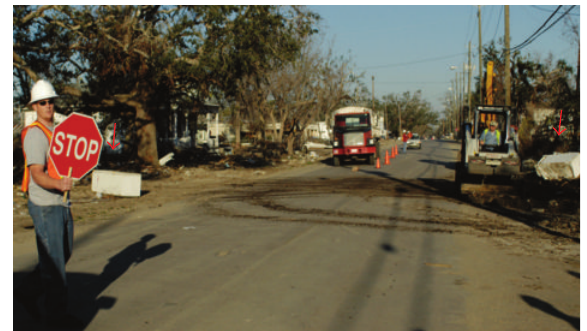
Figure 7: White goods placed in ROW to facilitate easy pick up in Pass Christian, MS.